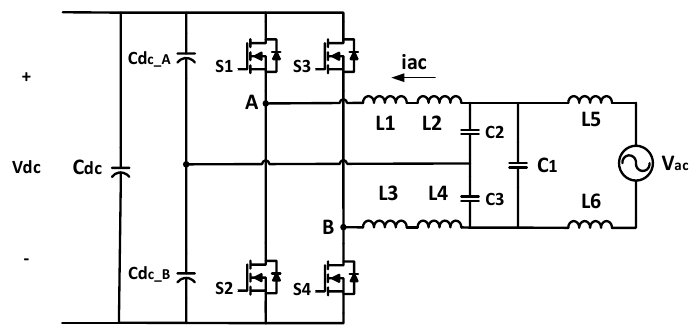
Figure 7 . Modified H4 bidirectional full-bridge topology with EMI structure [44]. Figure 7. Modified H4 bidirectional full-bridge topology with EMI structure [44].